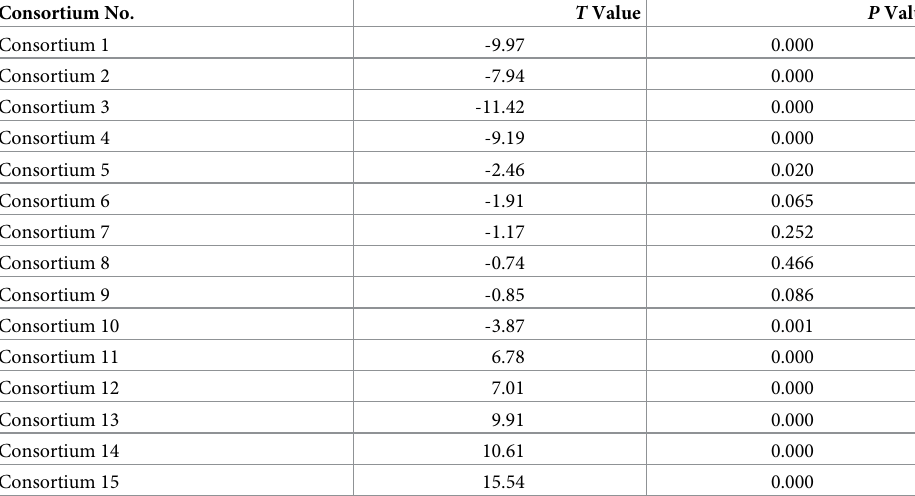
Table 5. ANOVA of fungal consortium producing laccase. Consortium